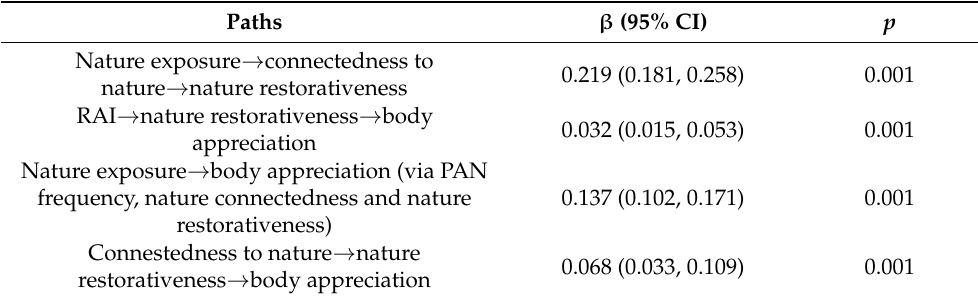
Table 4. Summary of mediation analyses testing the indirect effect between study variables ( n = 924). Paths β (95% CI) p Nature exposure → connectedness to 0.219 (0.181, nature → nature restorativeness